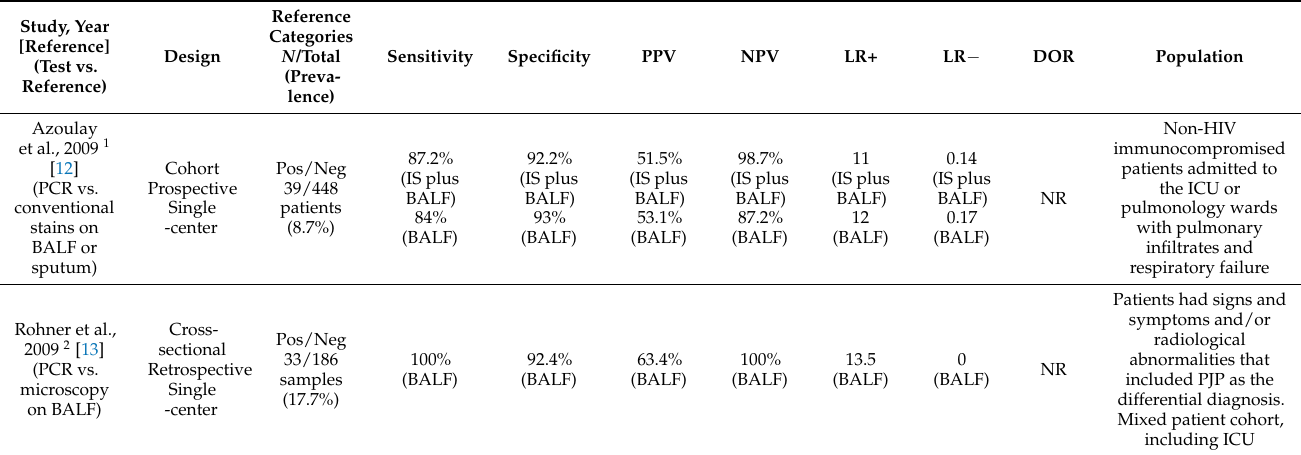
Table 1. Studies assessing the performance of PCR for the diagnosis of PJP in critically ill patients.